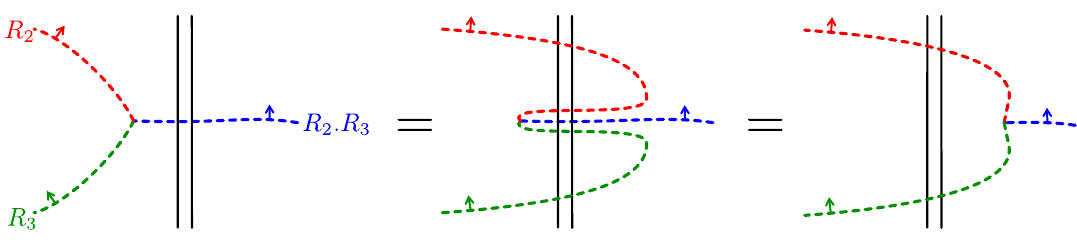
Figure 3 . The monodrony condition (2.10) ensures that the cuts can cancel each other at a face of the diagram. It allows us to drag the meeting point freely across the